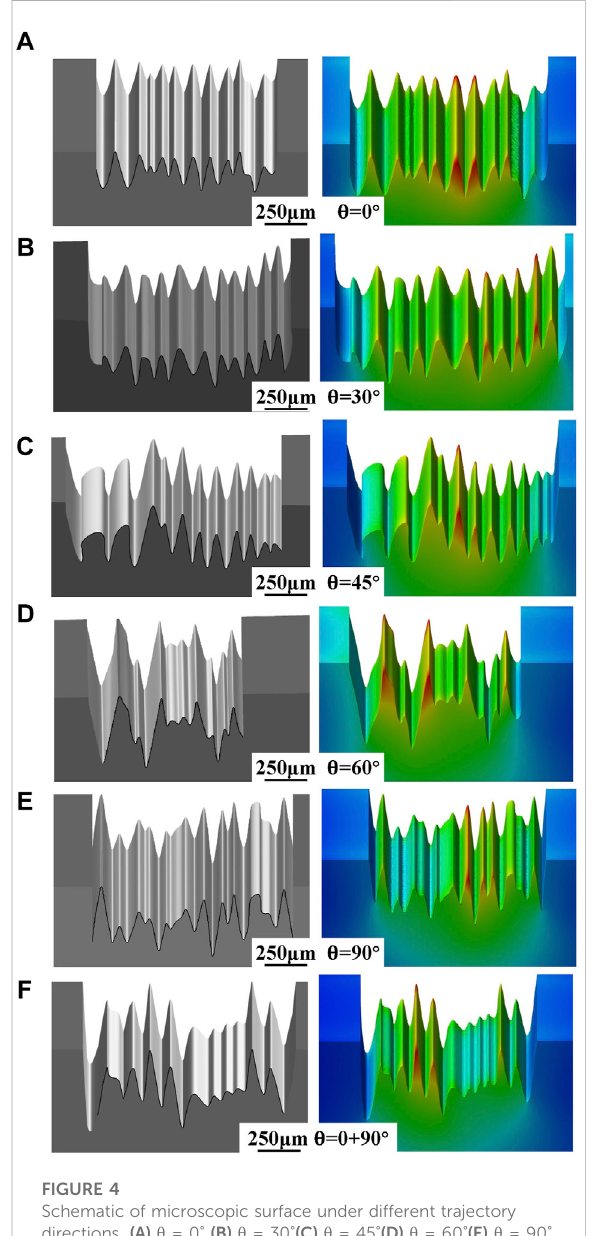
FIGURE 4 Schematic of microscopic surface under different trajectory directions. (A) θ = 0 ° (B) θ = 30 ° (C) θ = 45 ° (D) θ = 60 ° (E) θ = 90 ° (F) θ = 0 + 90 °